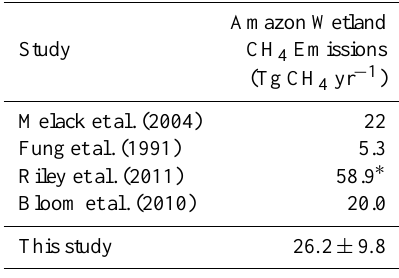
Table 2. Estimates of total annual Amazon River basin